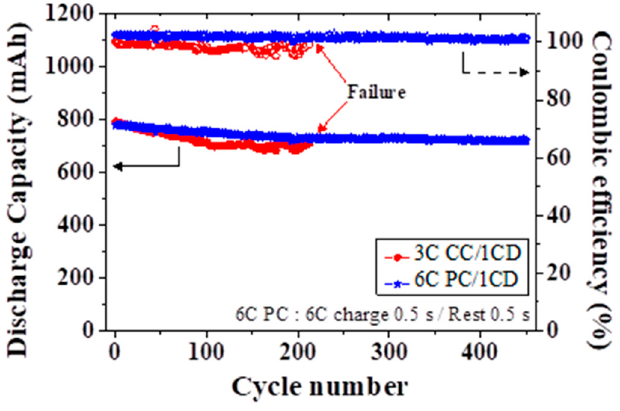
Figure 3. Discharge capacity and Coulombic efficiency.